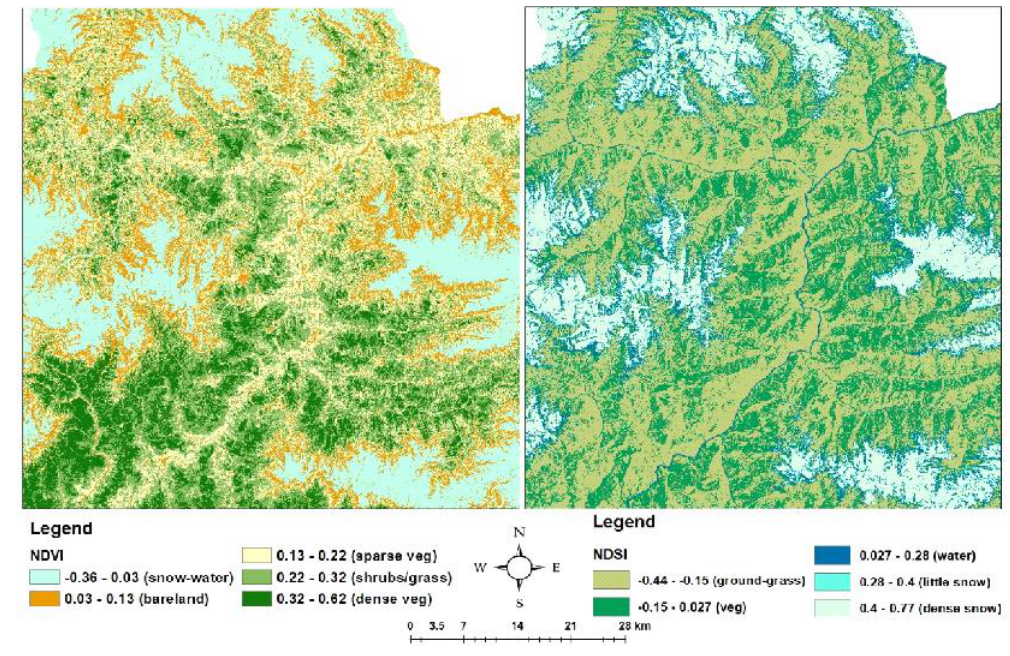
Fig. 2: Classification of NDVI and NDSI images.